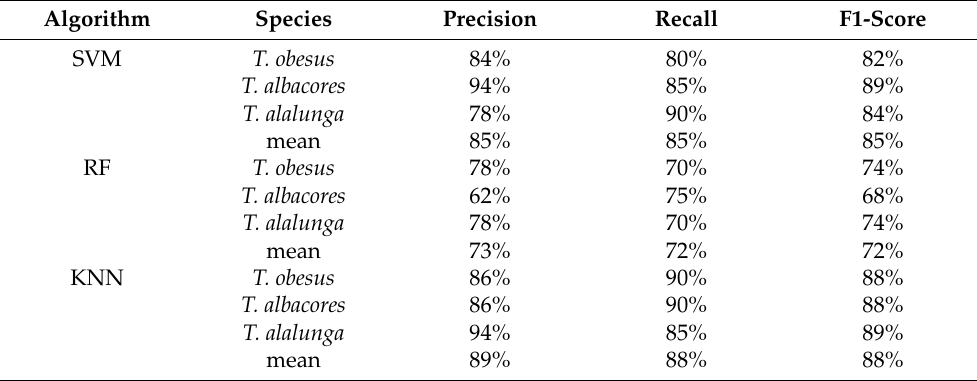
Table 3. Values of performance evaluation metrics obtained using EFT features.